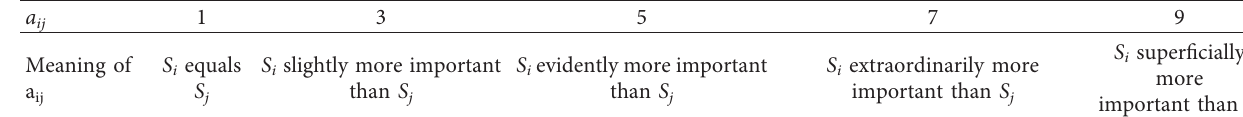
Table 2: Corresponding meanings of different relative importance values.